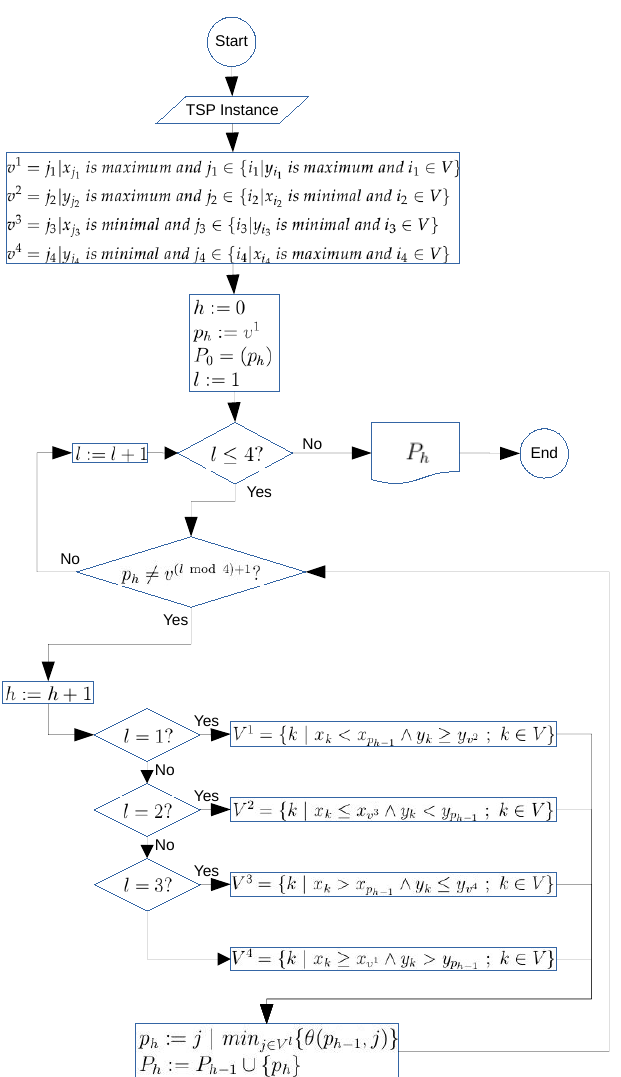
Figure 4. Girding polygon algorithm